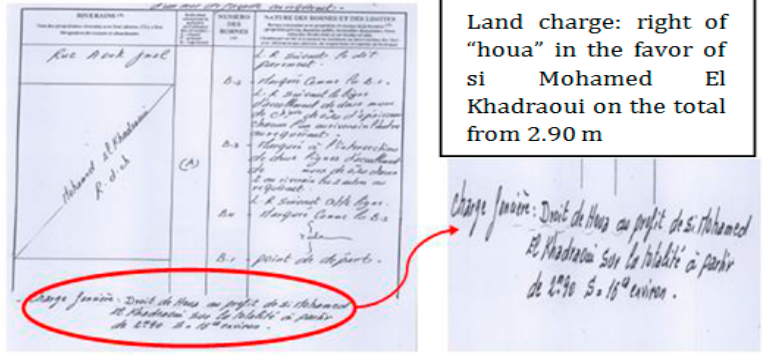
Figure 2. Verbal description of the right of “houa” in a sketch of